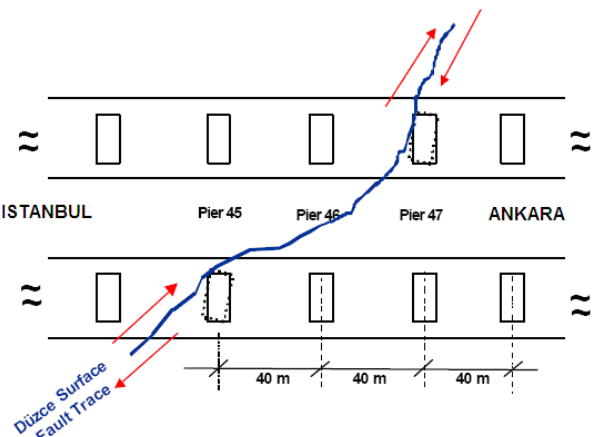
Fig. 4. Fault trace at the viaduct (Ghasemi et al., 2000). Figure 4: Fault trace at the viaduct (Ghasemi et al., 2000)